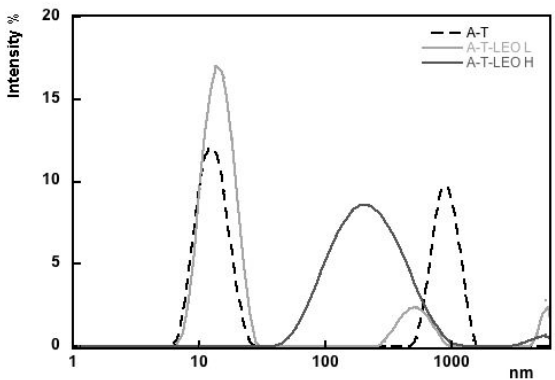
Figure 2. Particle size distribution of a suspension of alginate and Tween 80 (dashed black line), of primary alginate/lemongrass essential oil (LEO) emulsions with low (solid grey line) and high (solid black line) oil content.